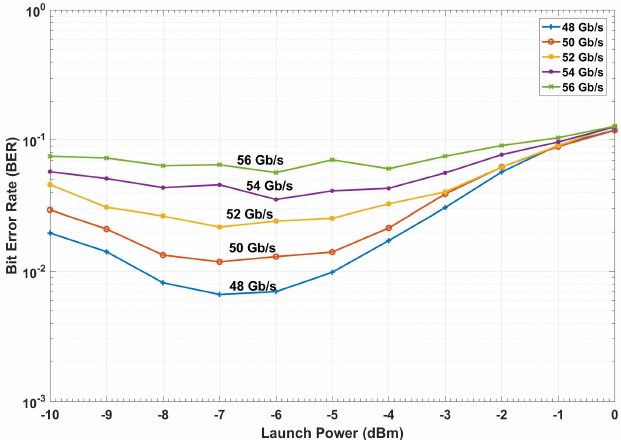
Figure 15. The simulation of a conventional system with a linear equalizer.